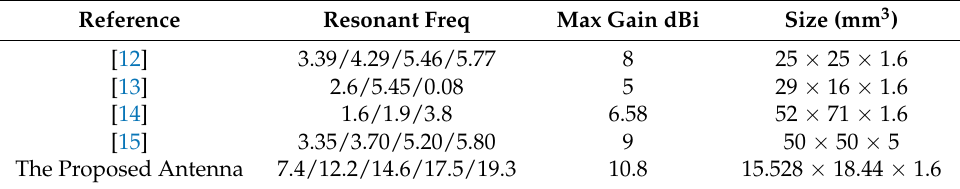
Table 3. Comparison between the proposed antenna and other similar microstrip antennas.